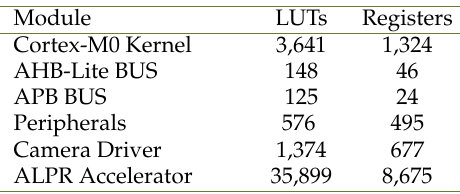
Table 1. SoC Resource Consumption